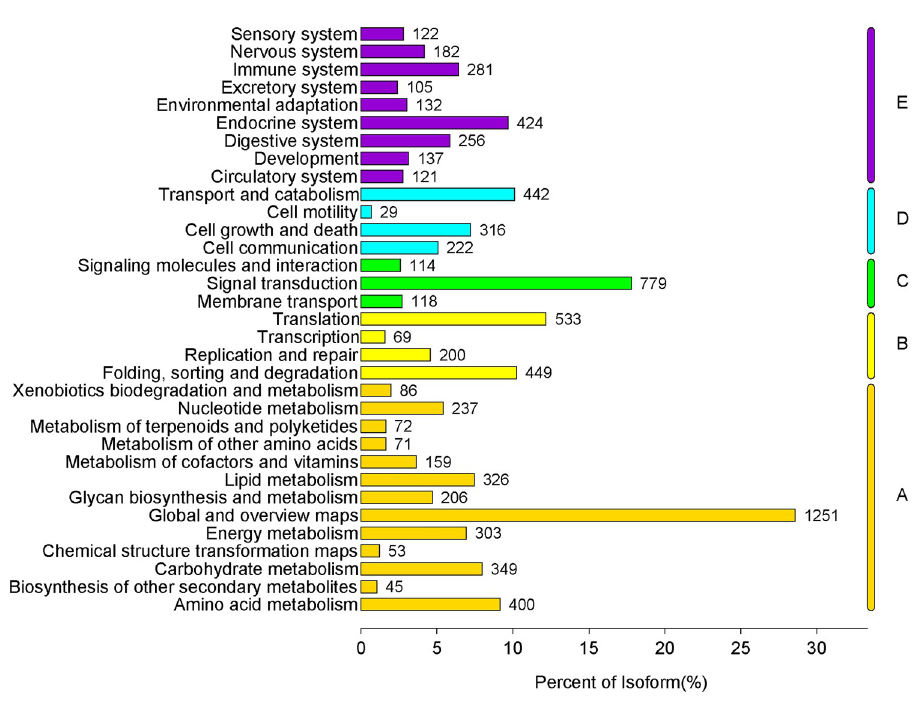
Fig 4. KEGG classification of S . insularis unigenes.